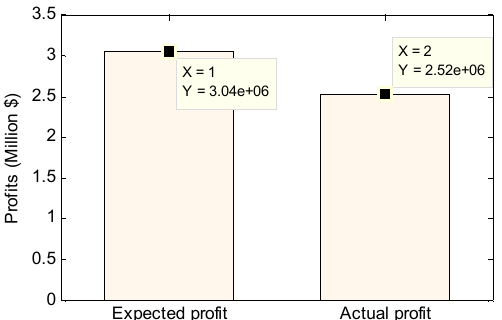
Figure 13. Expected and actual profits for the case of operating the EV aggregator.